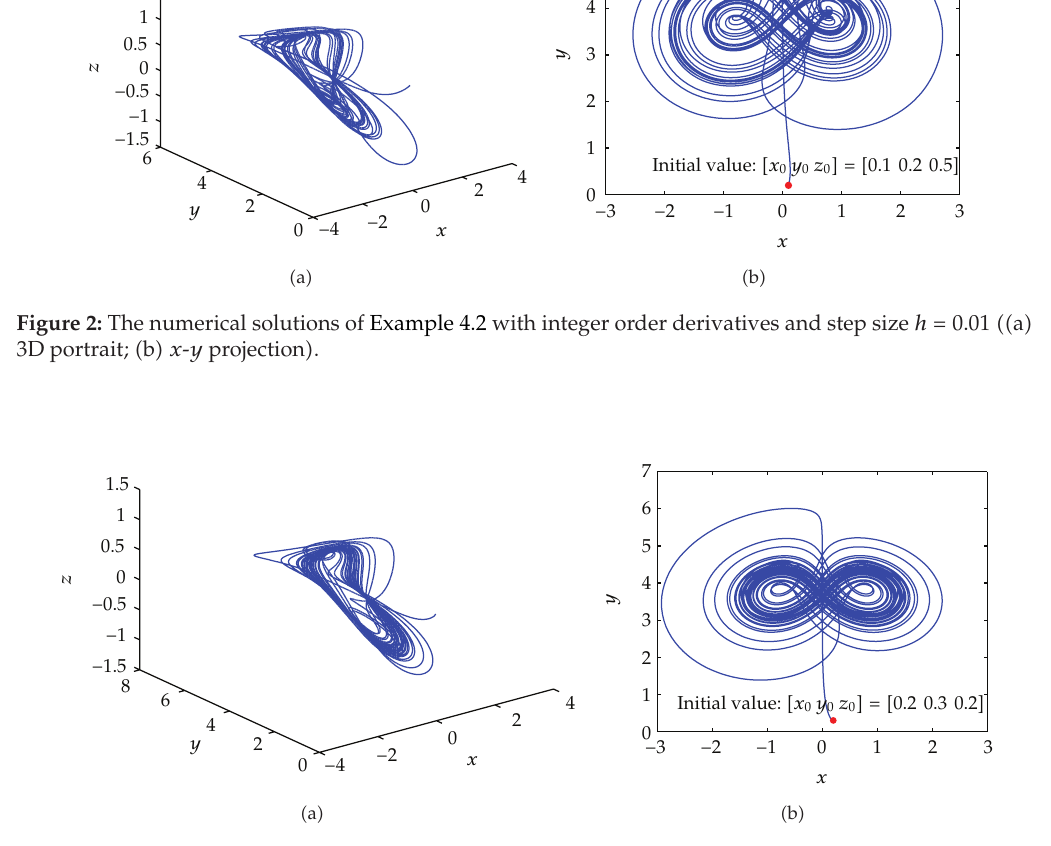
exhibits chaotic motion. The largest Lyapunov exponent of the system is 0 . 2292. The following Figure 2 shows our numerical